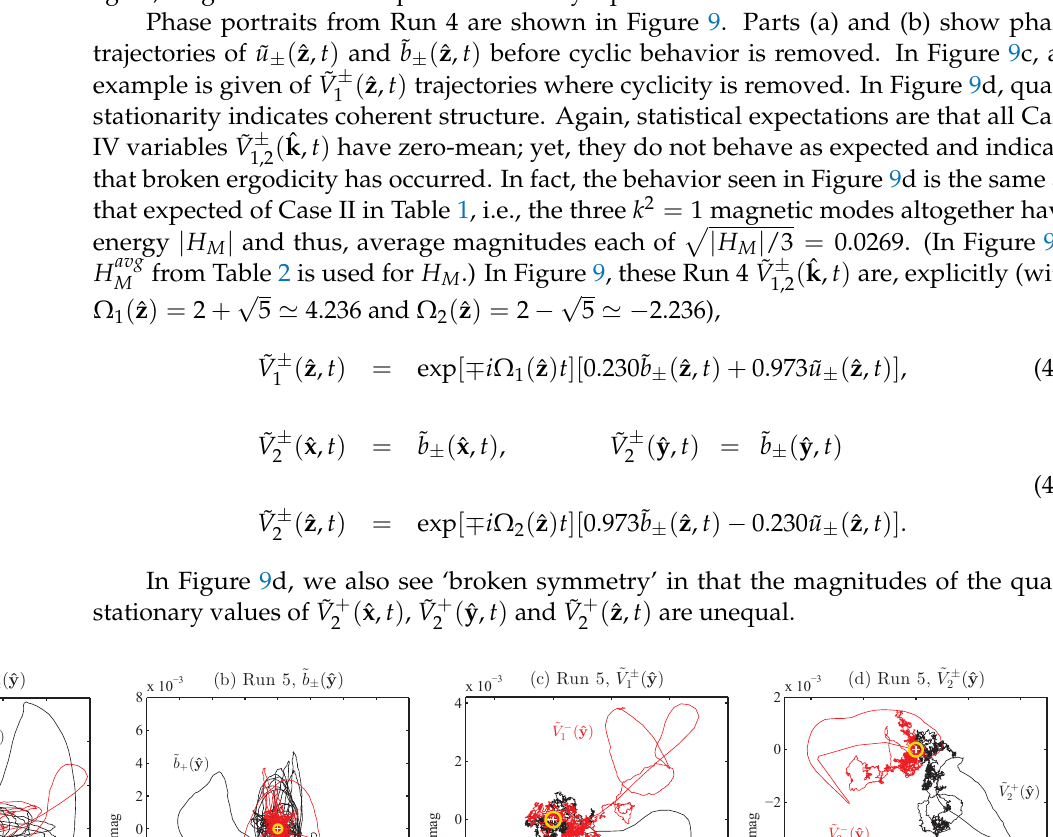
H M /3 = 0.0269. (In Figure 9d, | | (cid:112)